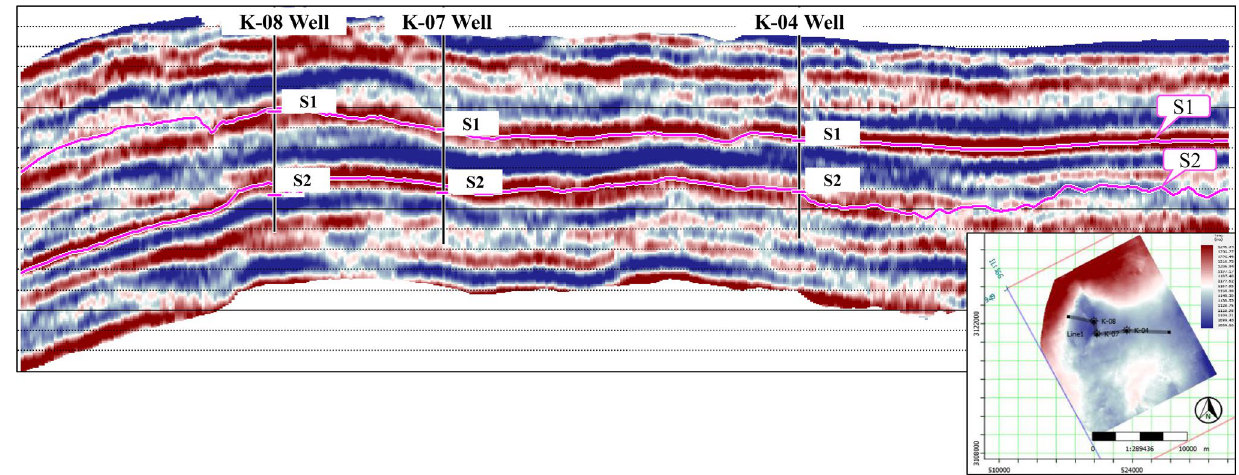
Fig. 11 Multi-wells well to seismic tie analysis—arbitrary seismic line passing through three